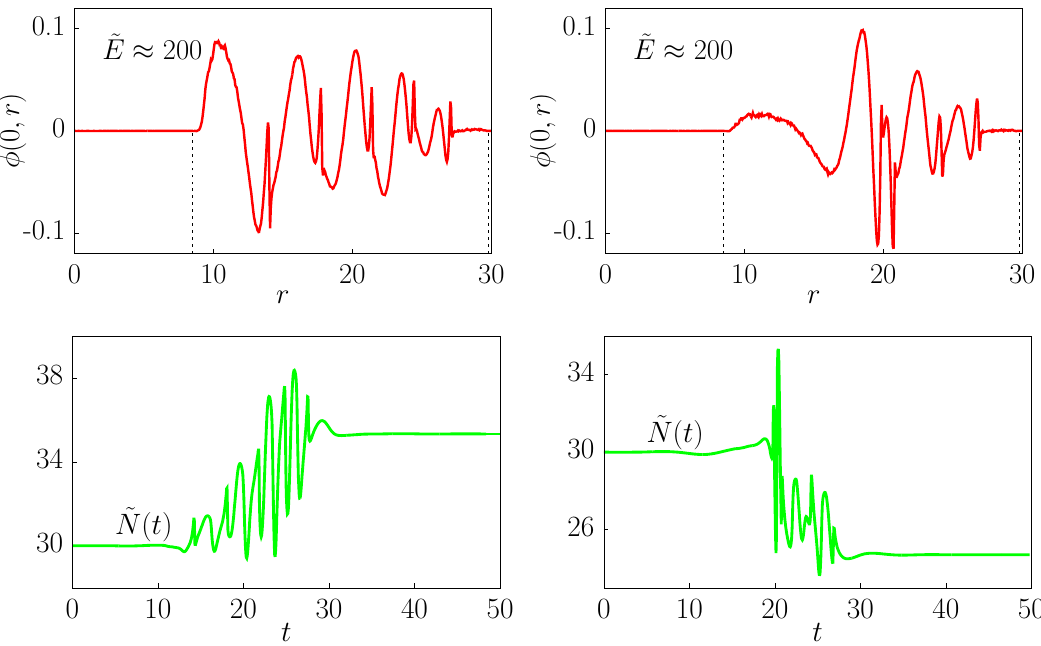
Figure 17 . The initial wave packets (left panels) and evolution of the instantaneous particle number (right panels) for the boundary solutions with ~ N i = 30 and ~ E (cid:25) 200. Upper and lower panels correspond to ~ N f > ~ N i and ~ N f < ~ N i